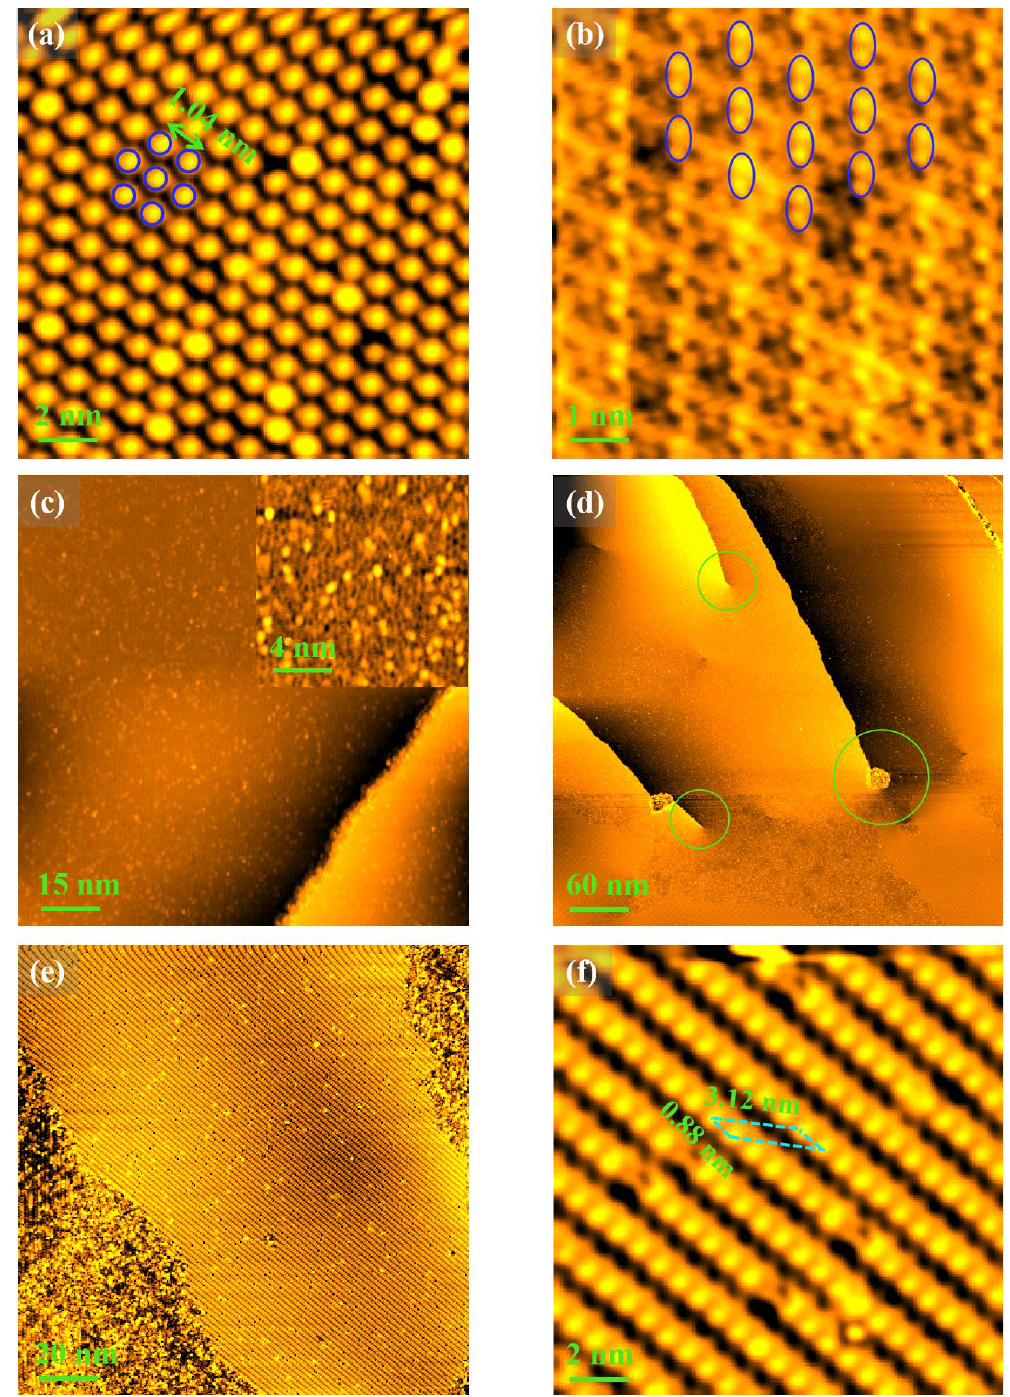
Figure 6. Surface structures from Process Ⅳ to Ⅵ . ( a , b ) High-resolution STM images (V = 0.5 V; I = 0.1 nA) from Process Ⅳ ； the blue circles mark the Cu atoms ( a ) and the blue ellipses mark the “double - atom” structures ( b ); ( c ) STM image (V = 1 V; I = 0.1 nA) from Process Ⅴ sample, where the inset corresponds to the enlarged STM image, showing the disordered surface structure; ( d ) STM image (V = 1 V; I = 0.1 nA) from the Process Ⅵ sample, showing screw dislocations on the coexistence surface between disorder state and reconstruction, as labeled by the green circles; ( e ) a higher-reso- lution STM image showing a type of reconstruction with many defects on the disordered surface. ( f ) An atomic-resolution STM image of the reconstruction region. The scanning bias voltage and current are equal to 0.5 V and 0.1 nm, respectively.